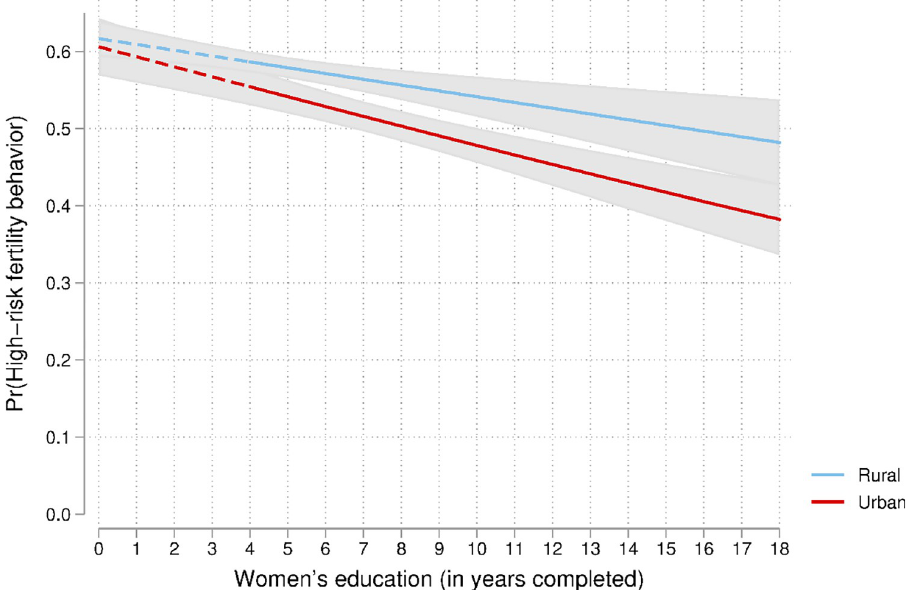
Fig 1. Predicted probability of high-risk fertility behaviour by women’s education and place of residence among married women in the Democratic Republic of the Congo. Note: Group difference (rural vs urban) is significant ( p < 0.05) when lines are solid.